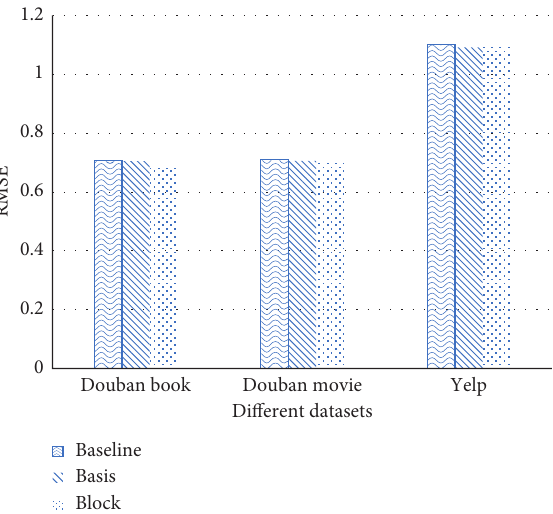
Figure 14: Normalization performance under